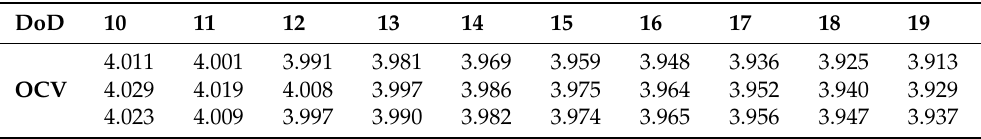
Table A2. OCV models parameters for DoD from 10% to 19%.